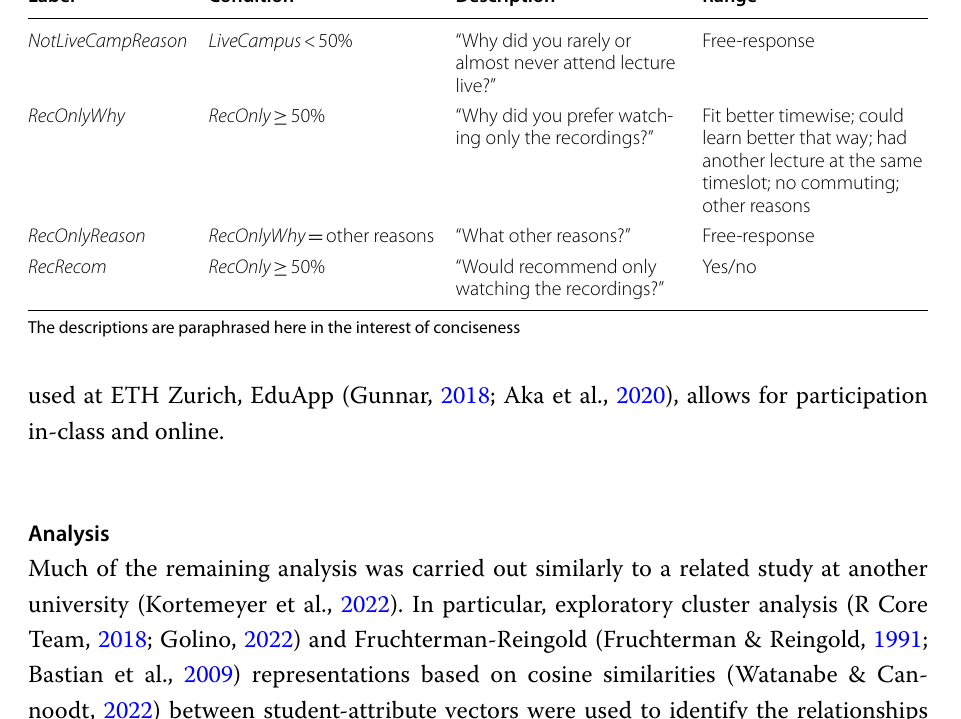
The descriptions are paraphrased here in the interest of conciseness